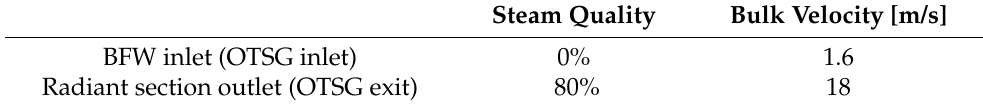
Table 18. Bulk velocity values at the BFW inlet and the radiant section outlet.